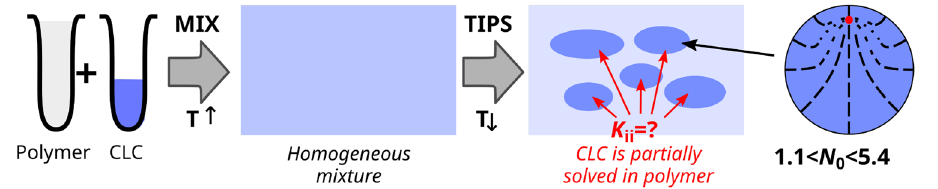
Figure 1. Principal scheme of preparation of polymer dispersed liquid crystalline material. After temperature- induced phase separation (TIPS), part of a liquid crystal remains solved in polymer, affecting the mixture contained in a